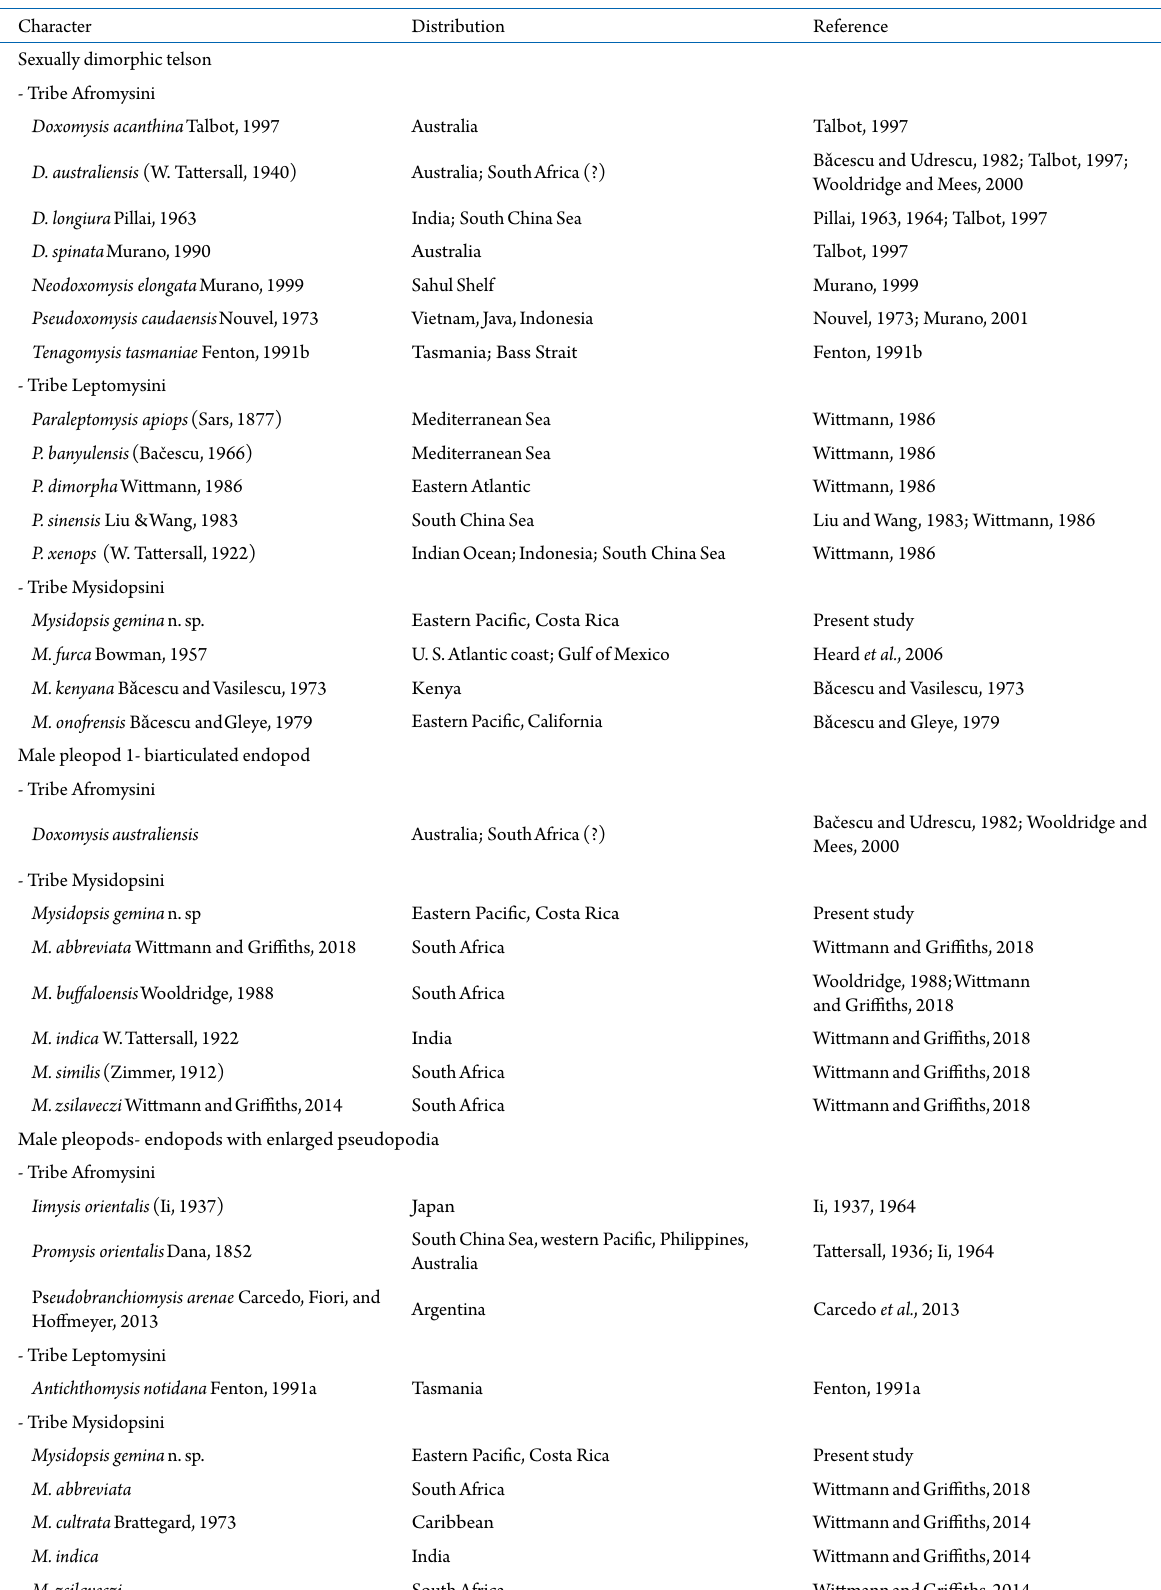
Table 2. Geographic distribution of the species described with three distinctive characters (sexually dimorphic telson, male pleopod 1 with biarticulated endopod, male pleopodal endopod with enlarged pseudopodia) among the three tribes of the subfamily Leptomysinae (including new Costa Rican